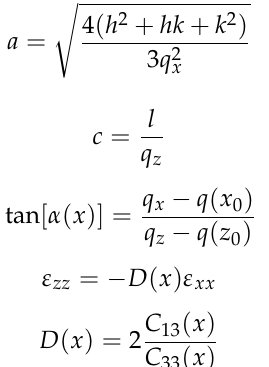
Figure 4. RSM results: ( a ) (0002) plane, ( b ) (11 2̅ 4) plane for central region, ( c ) (0002) plane and ( d ) (11 2̅ 4) plane for edge region. Table 1. Calculated in-plane strain components of the two strain-compensation Al x Ga 1−x N layers for both the wafer central and edge regions measured along the [11 2̅ 4] direction.